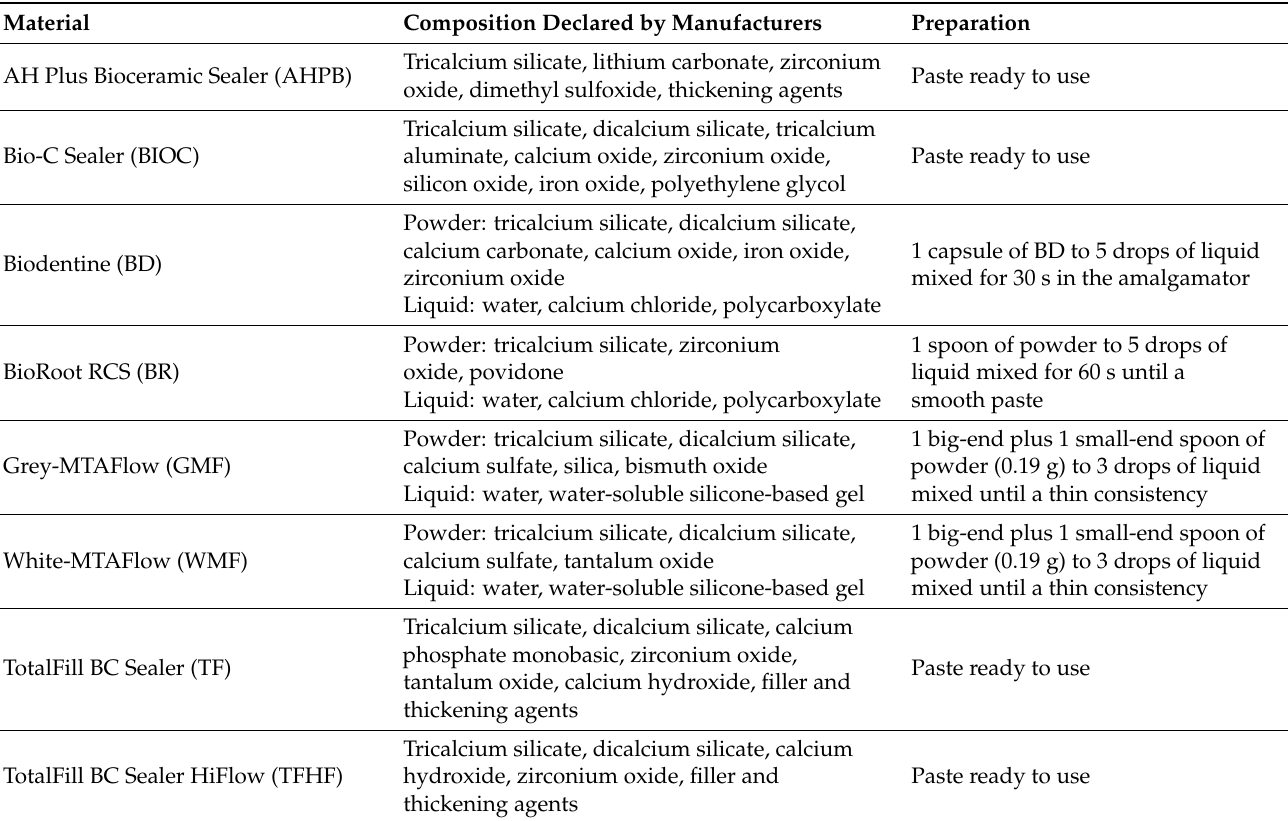
Table 1. Composition and preparation information of tested